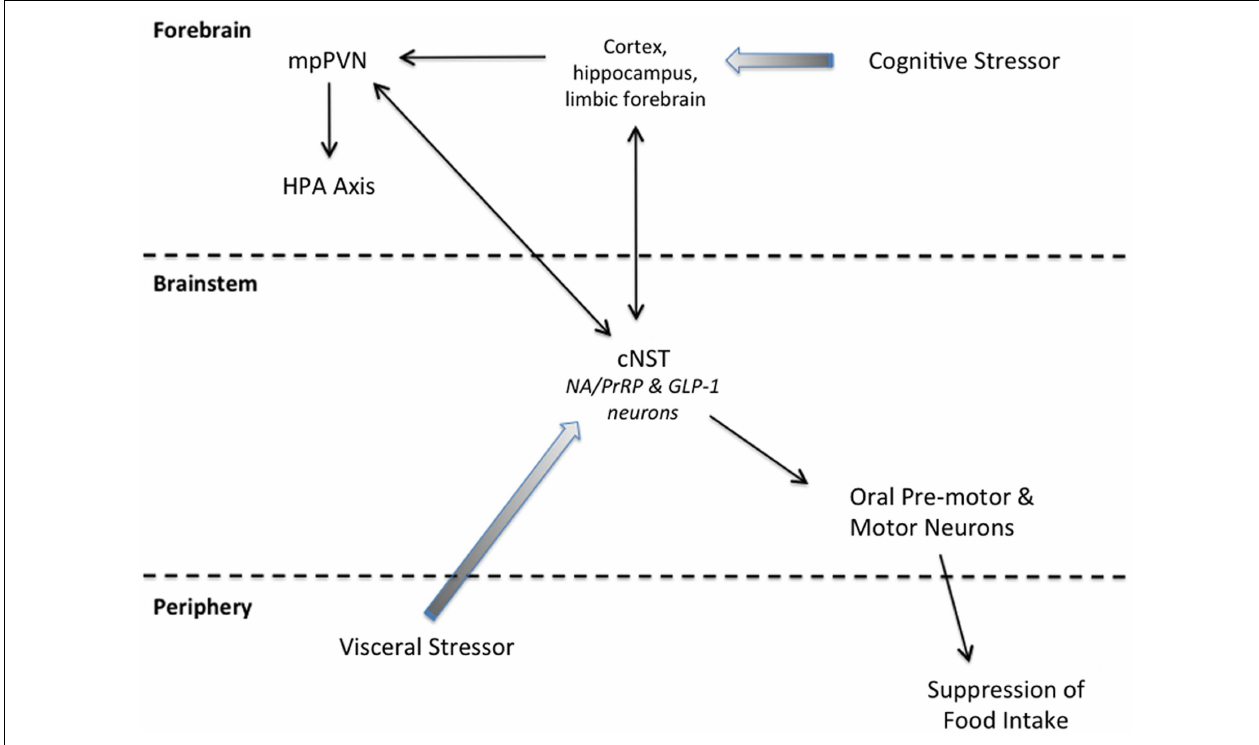
unconditioned stimuli that first engage cNST neurons (including PrRP and GLP-1 neurons) that innervate hypothalamic and limbic forebrain targets to recruit the HPA axis. Neurons within the cNST engage brainstem targets to organize ingestive motor